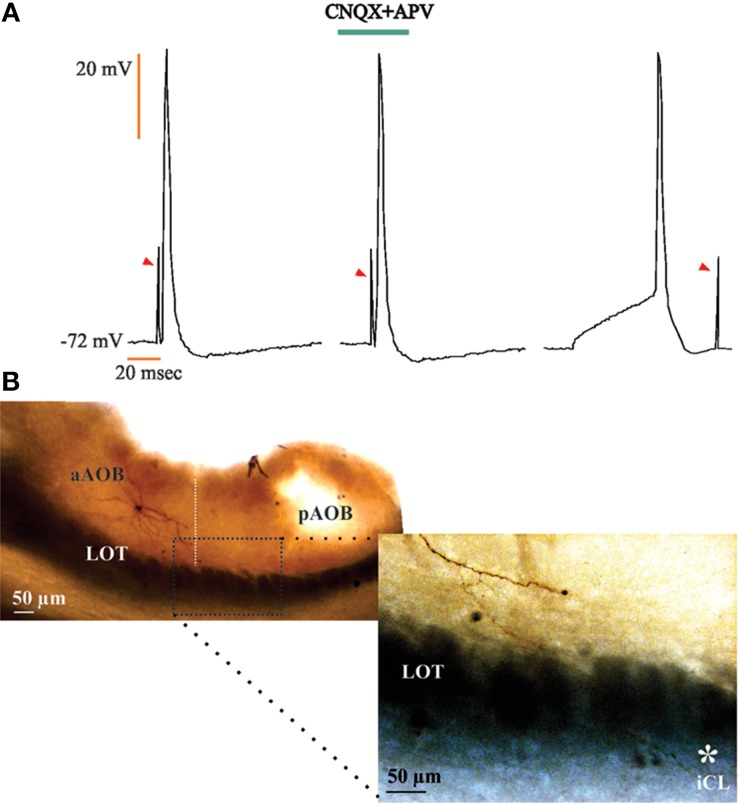
Large principal cells in the anterior half of the accessory olfactory bulb (aAOB) send axons to the homonymous cells in the posterior half (pAOB). (A) Action potentials evoked by opposite half AOB field stimulation (left); these responses persist in the presence of CNQX and APV (20 μM; center) and were always collided (right). Arrowheads: stimulation artifact. (B) Low power photograph of anterior and posterior AOB halves (upper left); an aAOB neuron sends a collateral fiber* that resolves in the opposite internal cellular layer (ICL; lower right).